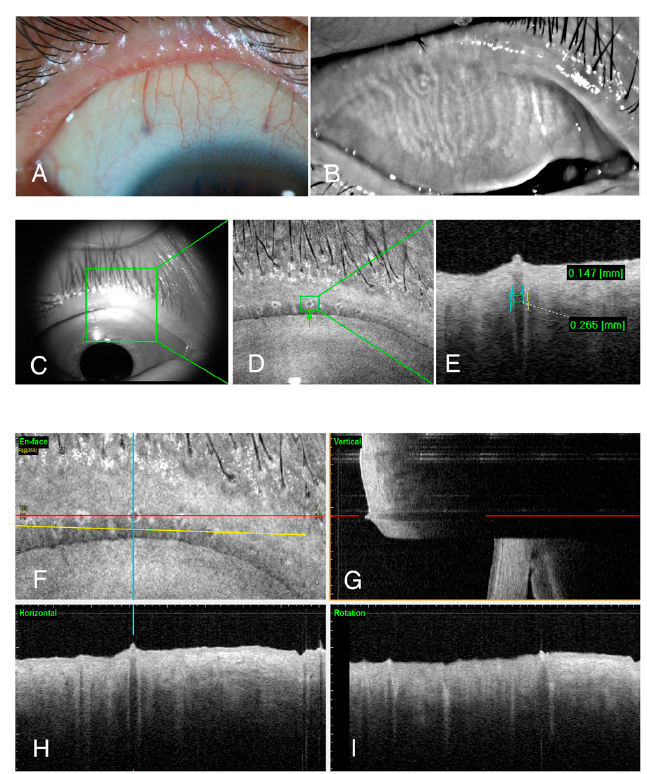
Figure 4. The eyelid margin and meibomian gland openings in patients with meibomian gland dysfunction (MGD). Each participant in this study underwent an eyelid margin photo ( A ), meibography of the upper eyelid ( B ), and an OCT examination ( C – I ). The chosen area for examination (green box in ( C )) shows enlarged orifices (green box in ( D )) and ducts ( E ). The diameter of both inner and outer maximal diameter of the terminal duct ( E ) can be numbered both vertically ( G ) or horizontally ( H ). With the help of the rotation line (yellow line in ( F )), any two of the tubes can be compared in the same picture ( I ).